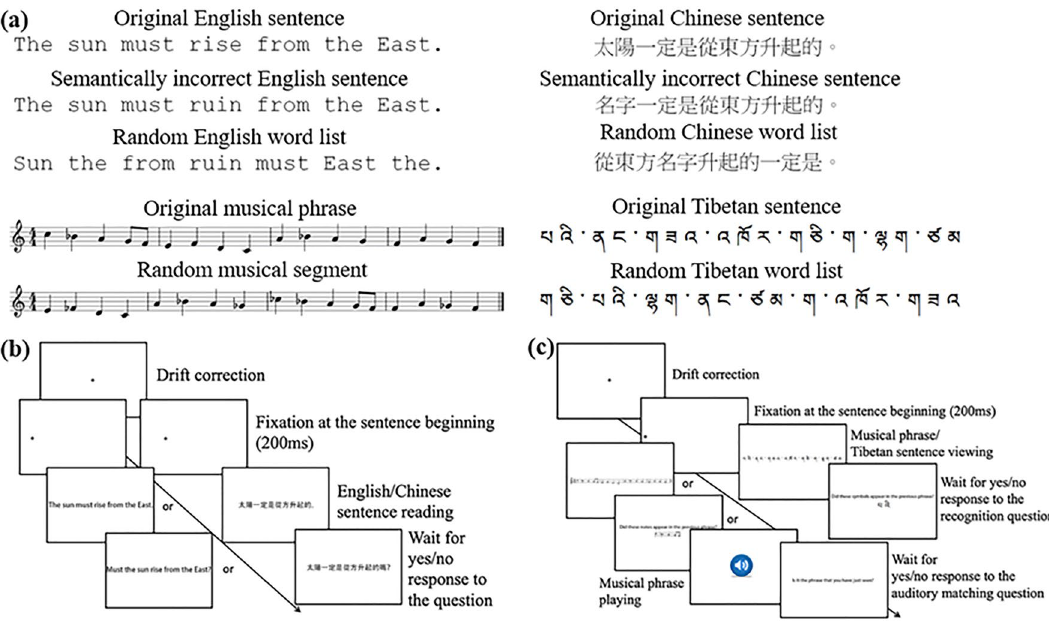
Figure 1. ( a ) Upper left are sample English stimuli; upper right are sample Chinese stimuli; lower left are sample musical stimuli; lower right are sample Tibetan stimuli. ( b ) Procedure of the English/Chinese reading task. ( c ) Procedure of the musical phrase/ Tibetan sentence viewing